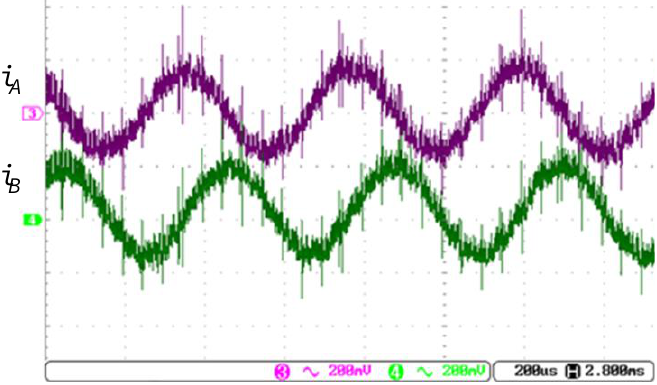
Figure 17. The phase currents A and B of the command of 3000 rpm (185 mV/A).